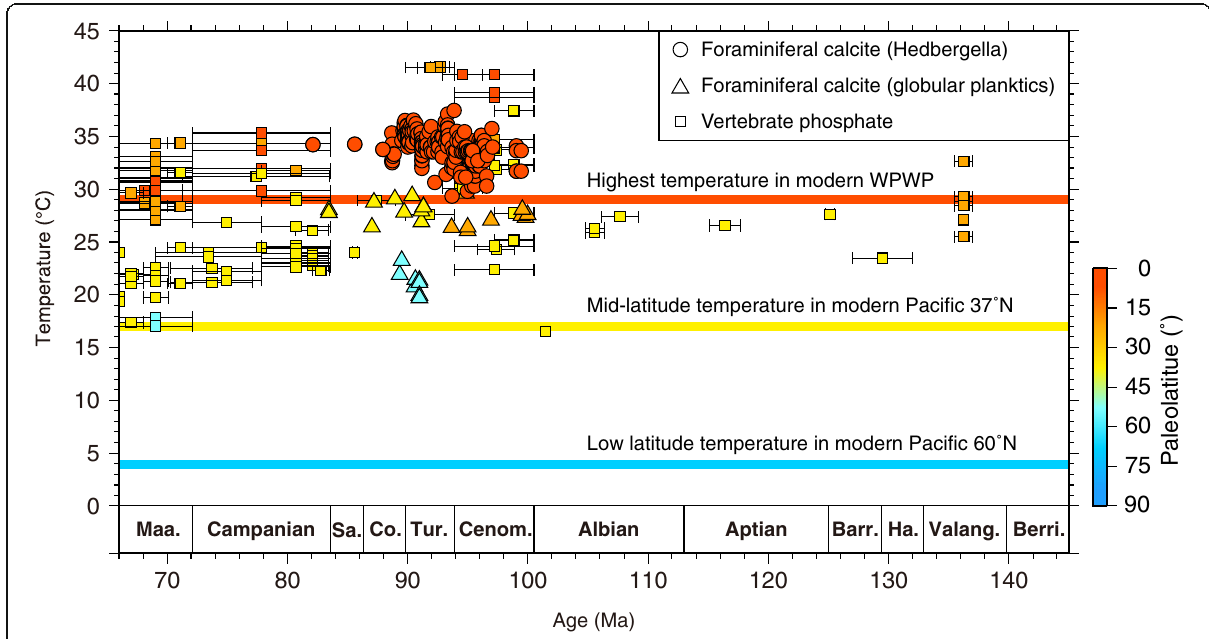
Fig. 14 Evolution of the Cretaceous ocean temperature estimated from oxygen isotopic records. Circles, triangles, and squares represent data from Hedbergella (planktic foraminifera), globular form planktic foraminifera, and surface dwelling vertebrate remains, respectively. Colors for each symbol indicate the paleolatitude where the data were obtained. While foraminifers were recovered from deep-sea cores, vertebrate remains occurred in outcrops, implying that vertebrate remains may not record open ocean temperatures. δ 18 O SW is estimated as − 1 ( ‰ , VSMOW) (Shackleton and Kennett 1975). δ 18 O SW is adjusted for latitudinal gradient in surface water δ 18 O SW (Zachos et al. 1994). Isotopic temperatures were calculated using the equations of Bemis et al. (1998) for foraminiferal calcites and Pucéat et al. (2010) for vertebrate remains. Paleolatitudes were computed by the Paleolatitude Calculator for Paleoclimate Studies (version 2.1) (van Hinsbergen et al. 2015) if they were not provided in the literature. Data are cited from Huber et al. (1999, 2002), Bice et al. (2003, 2006), Moriya et al. (2003; 2007; 2011), Pucéat et al. (2003, 2007), Forster et al. (2007), and Bornemann et al. (2008). Maa . Maastrichtian, Sa . Santonian, Co . Coniacian, Tur . Turonian, Cenom . Cenomanian, Barr . Barremian, Ha . Hauterivian, Valang .